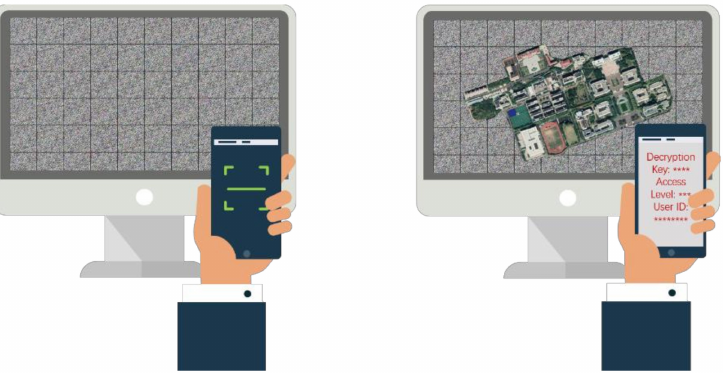
Figure 1. Application scenario of smartphone-based watermark reading and partial